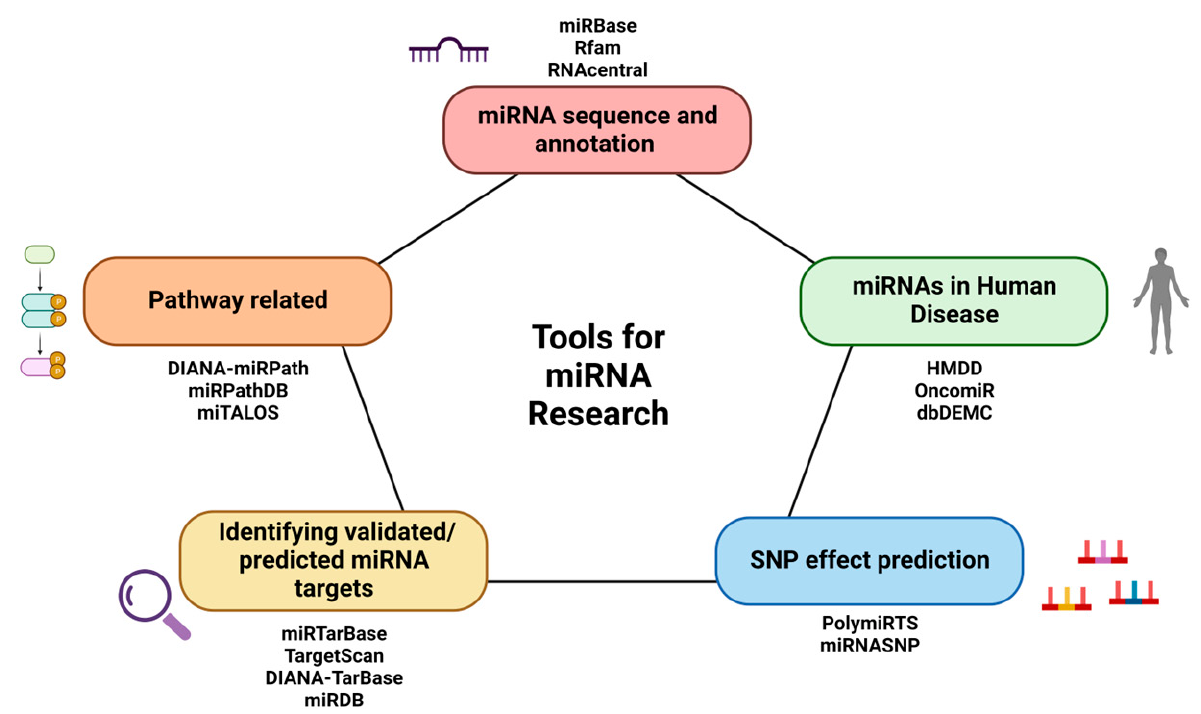
Figure 2. Schematic of available online microRNA-based bioinformatic tools. (Created with BioRen- der.com.).